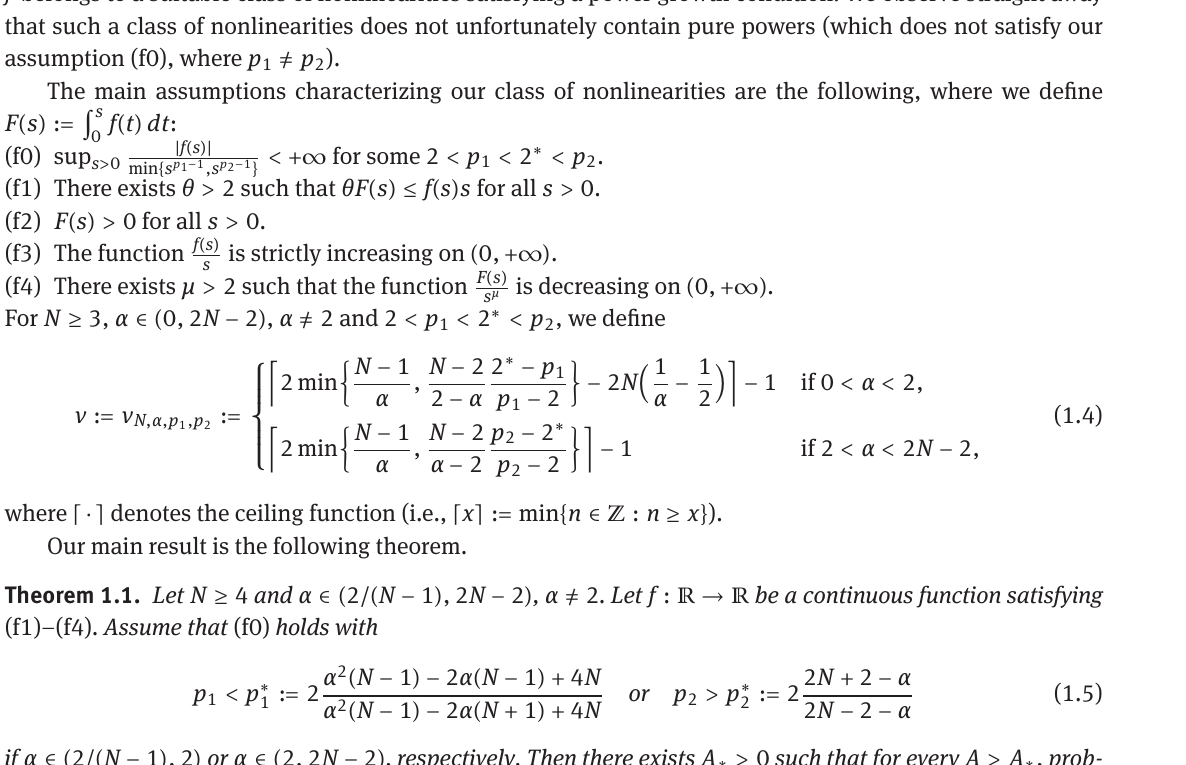
Figure 2: ν as a function of p 1 ∈ ( 2, p ∗ α ∈ ( 0, 2 ) fixed.